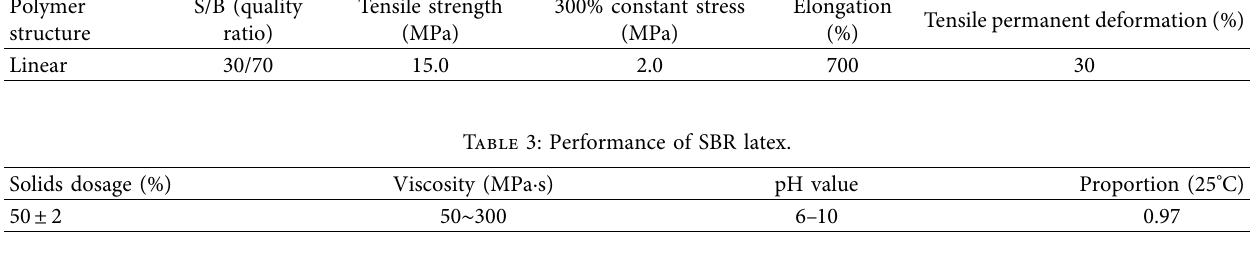
Table 4: Performance of VOD-7677 cationic fast-splitting emulsifer.